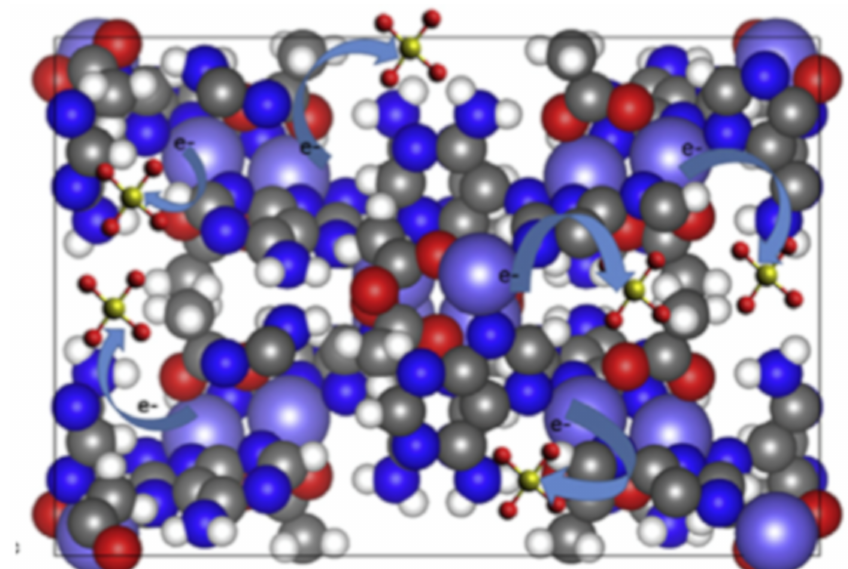
Figure 8. Representation of activation of peroxymonosulfate (PMS), used in catalytic degradation processes, by bio-MOF-11 where cobalt is purple, carbon is grey, oxygen is red, hydrogen is white and nitrogen is blue [68]. Reprinted from Chemosphere, 196, M. R. Azhar, P. Vijay, M. O. Tad é , H. Sun and S. Wang, Submicron sized water-stable metal organic framework (bio-MOF-11) for catalytic degradation of pharmaceuticals and personal care products, 105-114, Copyright (2019), with permission from